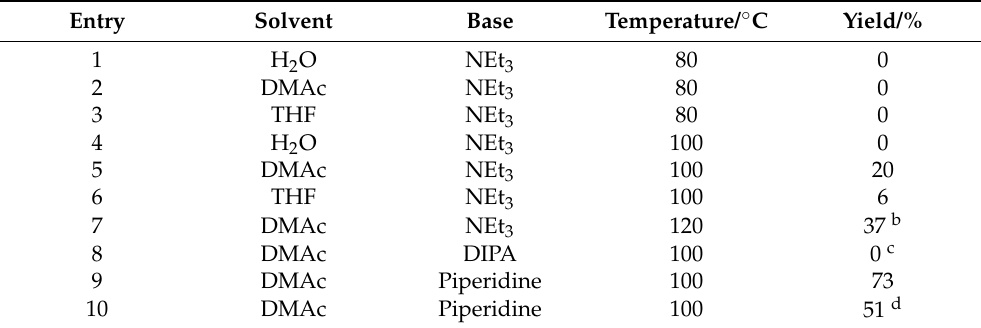
Table 5. Summary of the reaction conditions for the optimization of the Sonogashira cross-coupling reaction a .